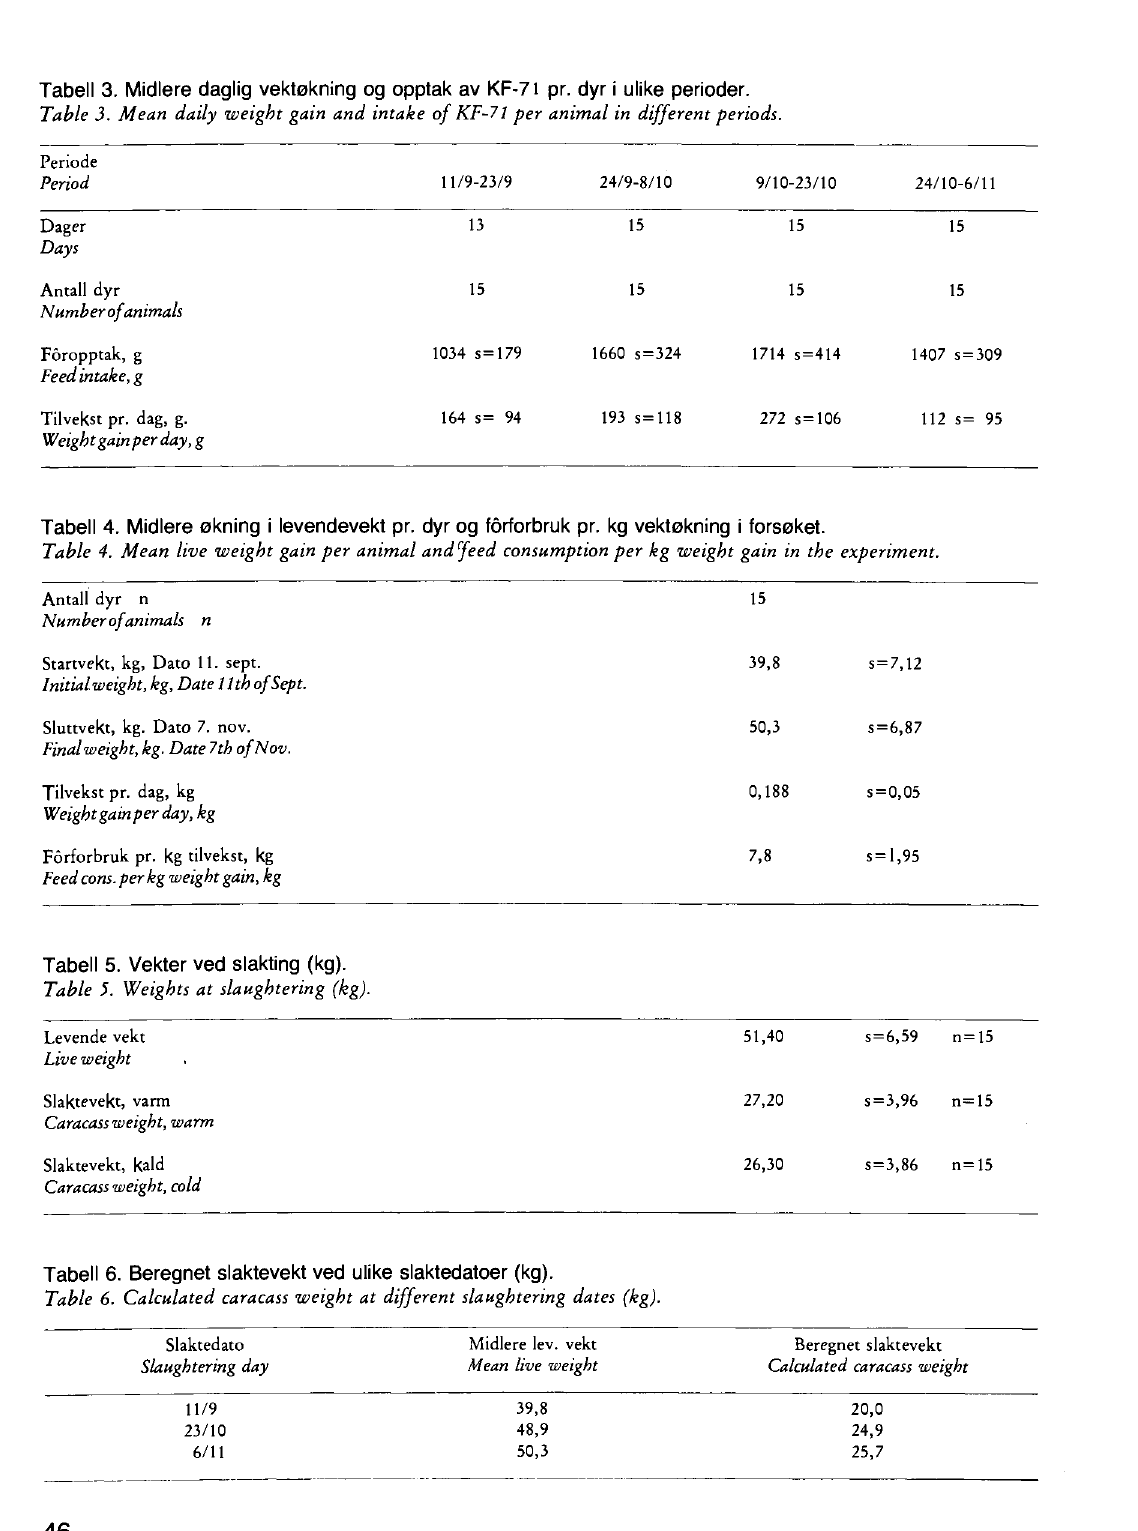
Table 3. Mean daily weight gain and intake of KF-71 per animal in different periods. Periode Period